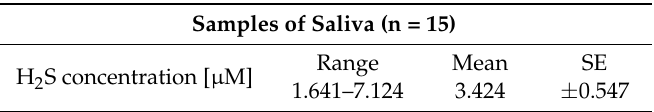
Table 1. Salivary H 2 S concentration in healthy